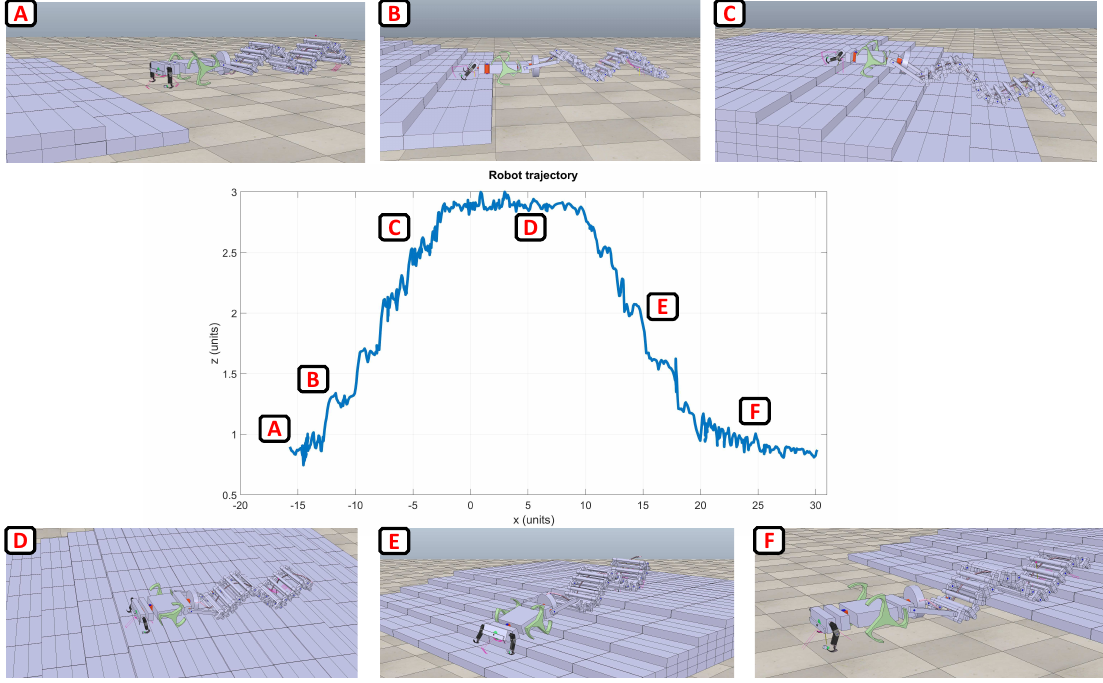
Figure 9. Trajectory followed by the robot in the x-z axis, during a climbing simulation with a stair-like obstacle. A series of snapshots illustrating the robot behavior is also included for different simulation steps.